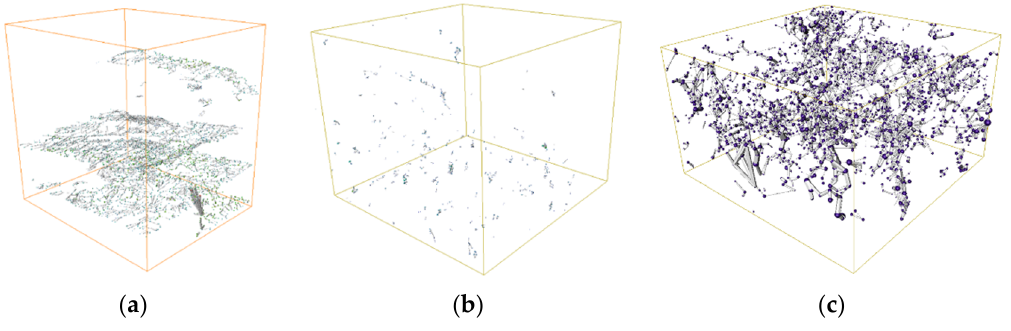
Figure 5. Extraction of shale multiscale network model: ( a ) microfracture; ( b ) micropore; and ( c ) nanopore.